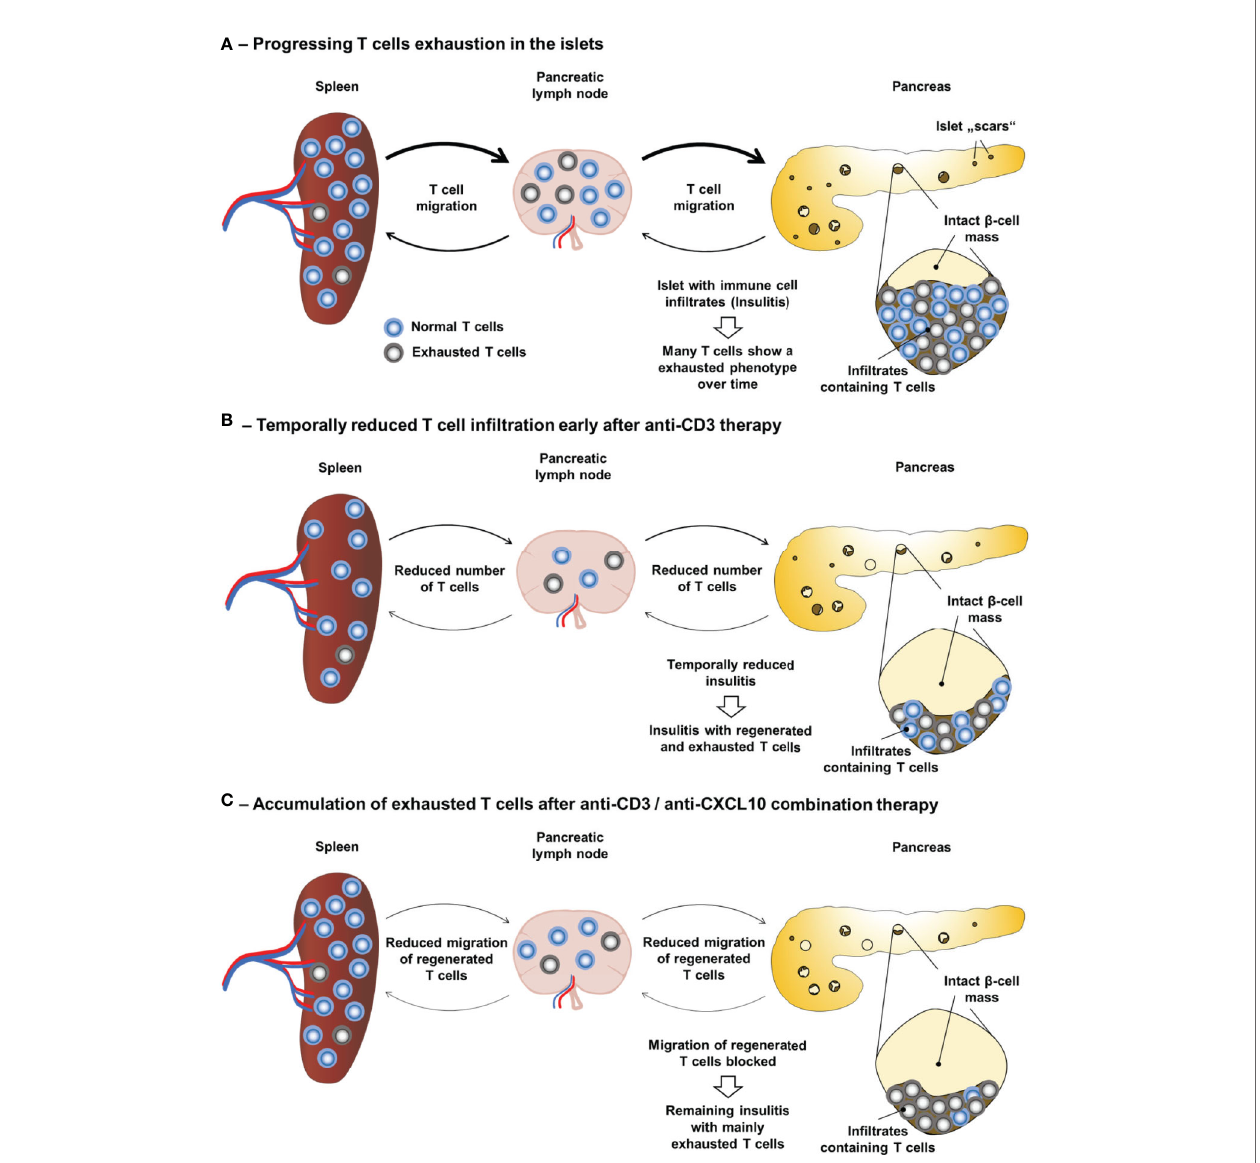
FIGURE 2 | Accumulation of exhausted T cells as possible explanation for the long-lasting effect of the anti-CD3/anti-CXCL10 combination therapy. (A) During the progressive destruction of b -cells in the RIP-LCMV-GP model the majority of islet autoantigen (LCMV-GP) speci fi c T cells enter a state of exhaustion. (B) Upon anti- CD3 therapy the frequency of T cells is temporarily reduced and the frequency of exhausted T cells is increased. However, upon termination of the anti-CD3 antibody treatment, newly regenerated T cells are not prevented from invading the islet microenvironment. (C) In contrast, anti-CD3/anti-CXCL10 combination therapy prevents the migration of newly regenerated, functionally active T cells to the islets and results in an increased frequency of exhausted islet autoantigen-speci fi c T cells in the islet